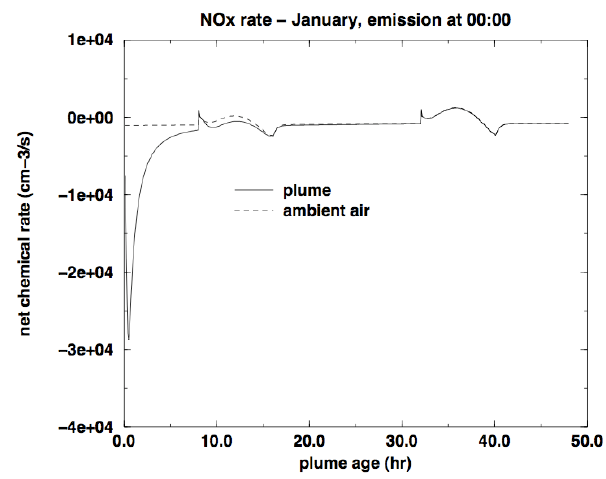
Fig. 5. Evolution of plume and background NO x chemical rate. The plume lifetime t p = t mix is defined as the time when the difference between the two rates is below a threshold value (Meijer,